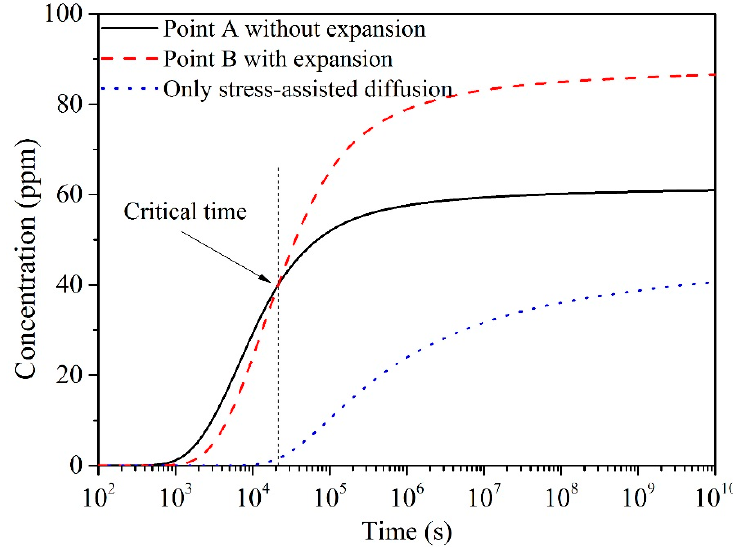
Figure 5. Evolution of hydrogen concentration at the critical position of the crack tip, where point A and B were the maximum concentration points in Figure 4.